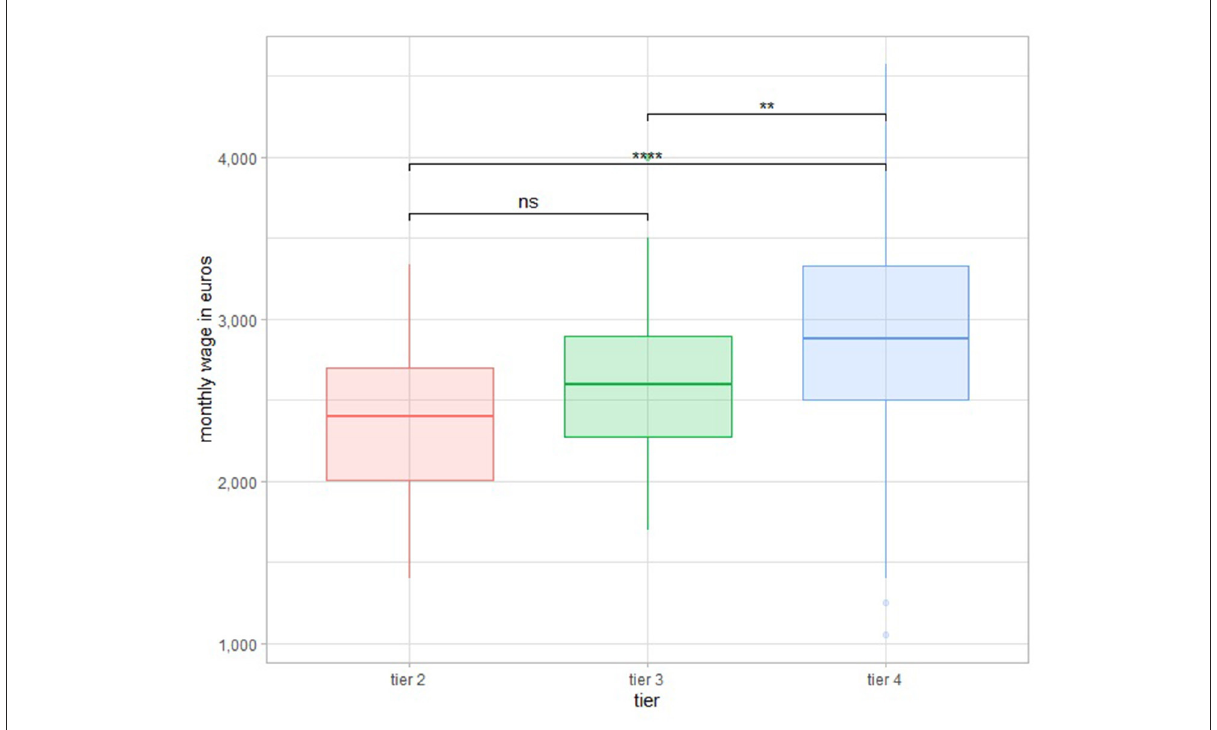
FIGURE4 Wage boxplots according to tiers. **P < 0.01; ****P <